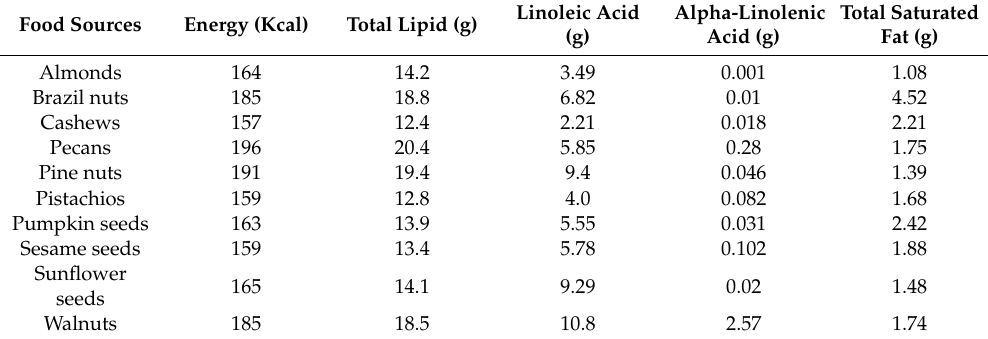
Table 2. Food sources of linoleic acid (per 1 ounce [28.3495 g]) 1